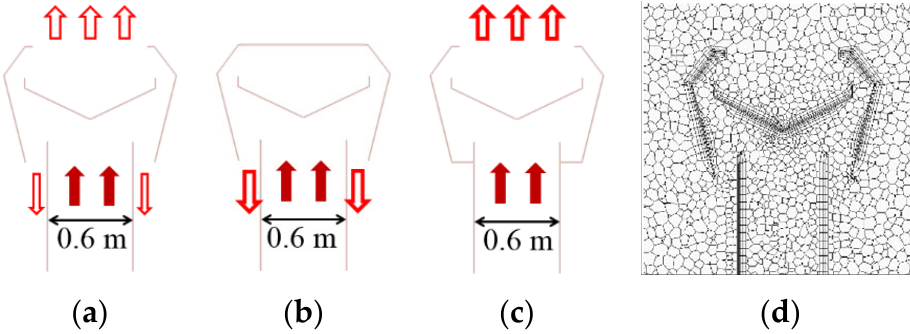
Figure 4. Three vent-mast outlet directions: ( a ) Upward and downward, ( b ) downward, ( c ) upward,